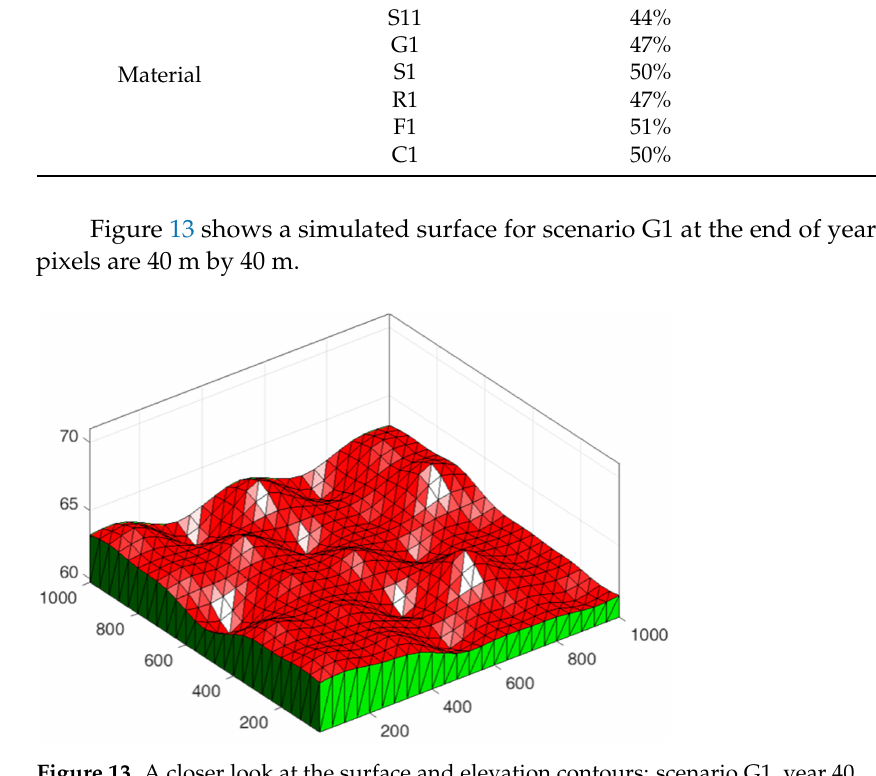
Figure 13. A closer look at the surface and elevation contours: scenario G1, year 40.